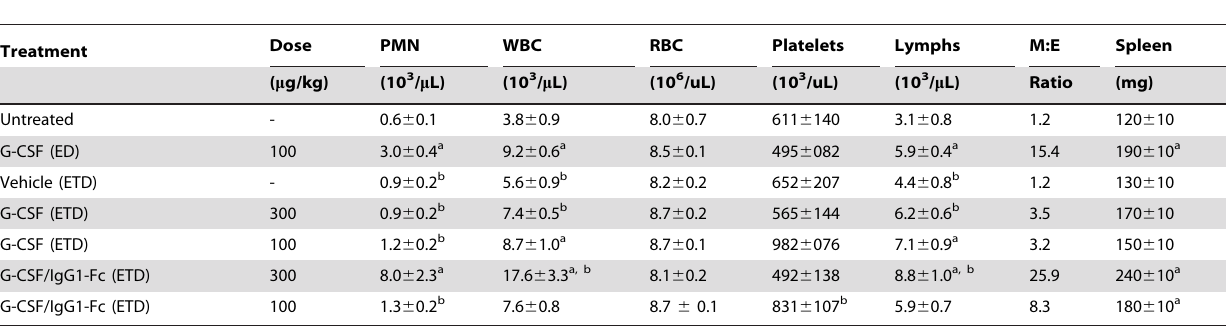
Table 3. Effect of every third day (dosing on days 1 and 4) dosing of G-CSF and G-CSF/IgG1-FcL on day 6 blood cell counts in mice.